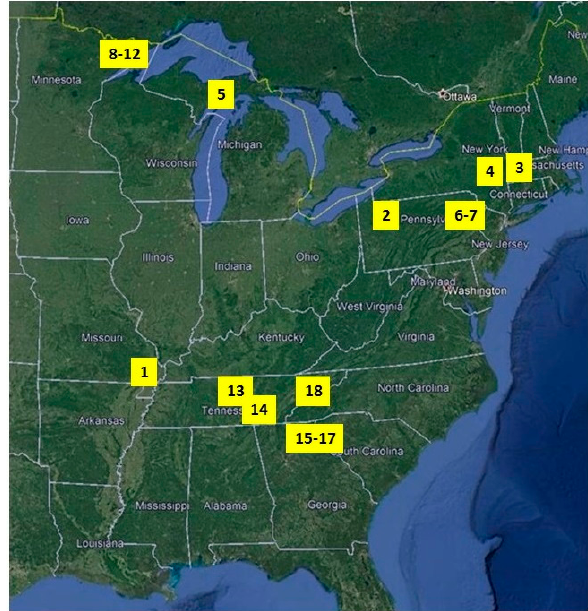
Figure 1. General location of 18 study sites within Eastern U.S. Multiple locations close together shown as a single box with multiple numbers. 1 = Mingo; 2 = Tionesta 1994; 3 = Gould Farm; 4 = Texas Hill; 5 = Rapid River; 6 = Taylor; 7 = Hattons; 8 = Fishhook; 9 = Meditation Lake; 10 = Shirttail; 11 = Twin; 12 = ThreeMile Island; 13 = Natchez Trace; 14 = Gum Road; 15 = Boggs Creek; 16 = Martin Branch; 17 = Timpson; 18 = Smokies.